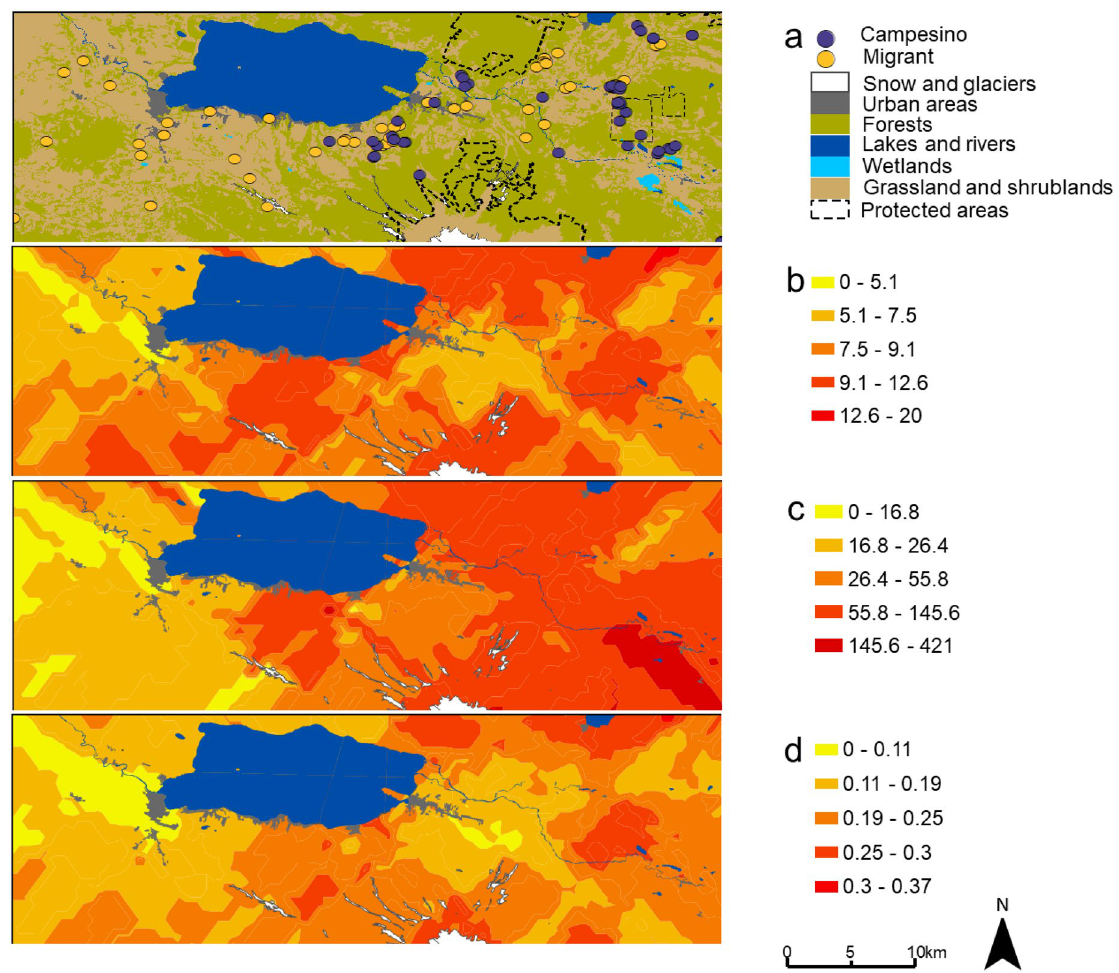
Figure 3. ( a ) Land cover and location of studied homegardens (campesino = blue dots, migrant = yellow dots) in Andean temperate ecosystems, southern Chile. Projection of ( b ) beetle species richness (number of species per homegarden); ( c ) relative abundance (total number of individuals per homegarden), and ( d ) functional richness (FRic value) in the study area. In ( b – d ), red shows areas of higher estimated values while yellow depicts areas of lower estimated values. Maps were generated using R software version 4.0.4 (R Core Team, 2021. R: A language and environment for statistical computing. R Foundation for Statistical Computing, Vienna, Austria. https:// www. Rproj ect.